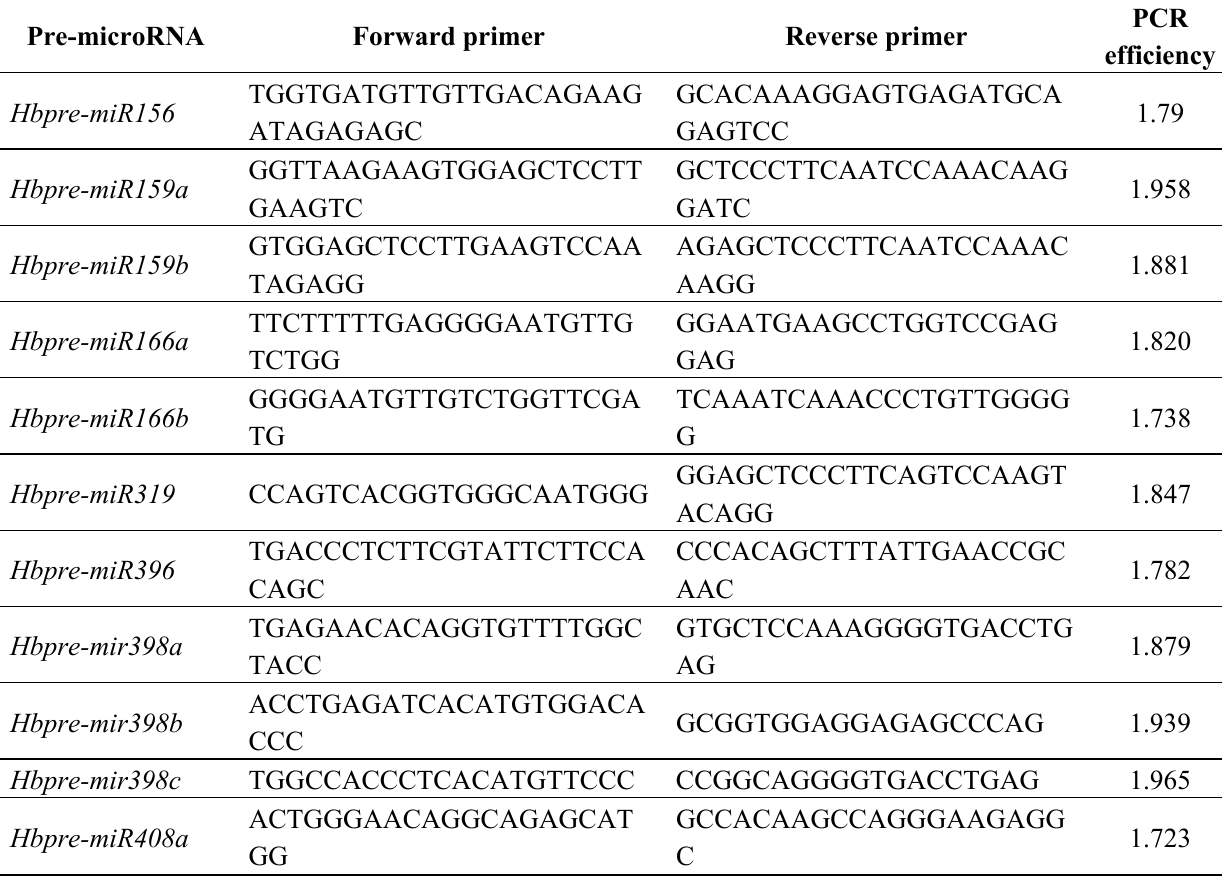
Table 3. List of primers and their sequences used for MIR gene expression analysis by RT-PCR. All primers are presented from 5' to 3'